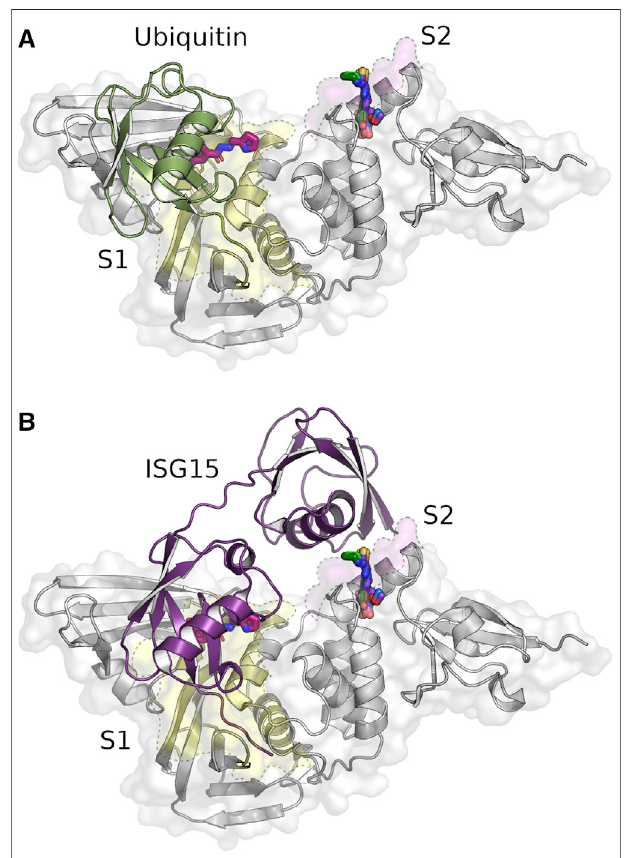
FIGURE 2 | Identi fi ed compounds bind near the S1 (yellow) and S2 site (pink) of PLpro. Crystal structure of SARS-CoV-2 PLpro in complex with the identi fi ed hydrazone H1and thiosemicarbazone binders T1-T5 overlayed with the binding ubiquitin [ (A) , green, PDB: 6xaa] and ISG15 molecules [ (B) , purple, PDB: 7rbs]. Five of the six identi fi ed ligands (T1 – T5) are in a deep pocket near the S2 site, while the hydrazone H1 (magenta) is located at the end of the S1